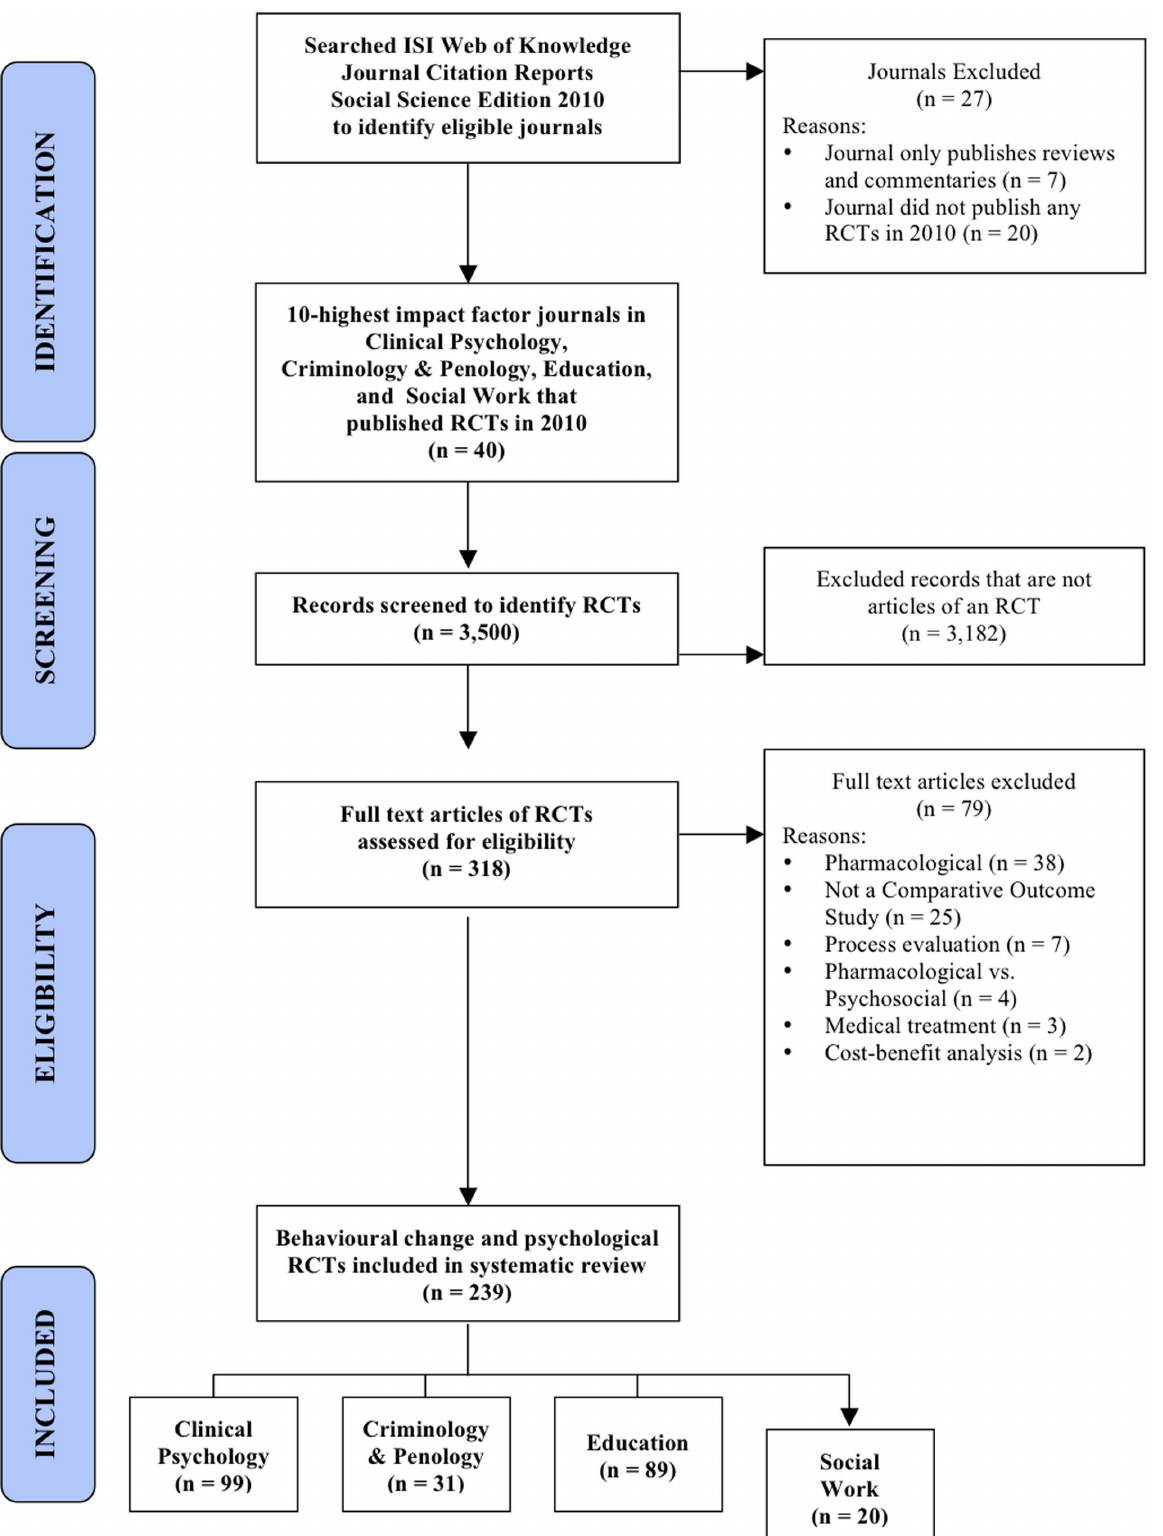
Figure 2. Flowchart of considered RCT publications through systematic literature search.